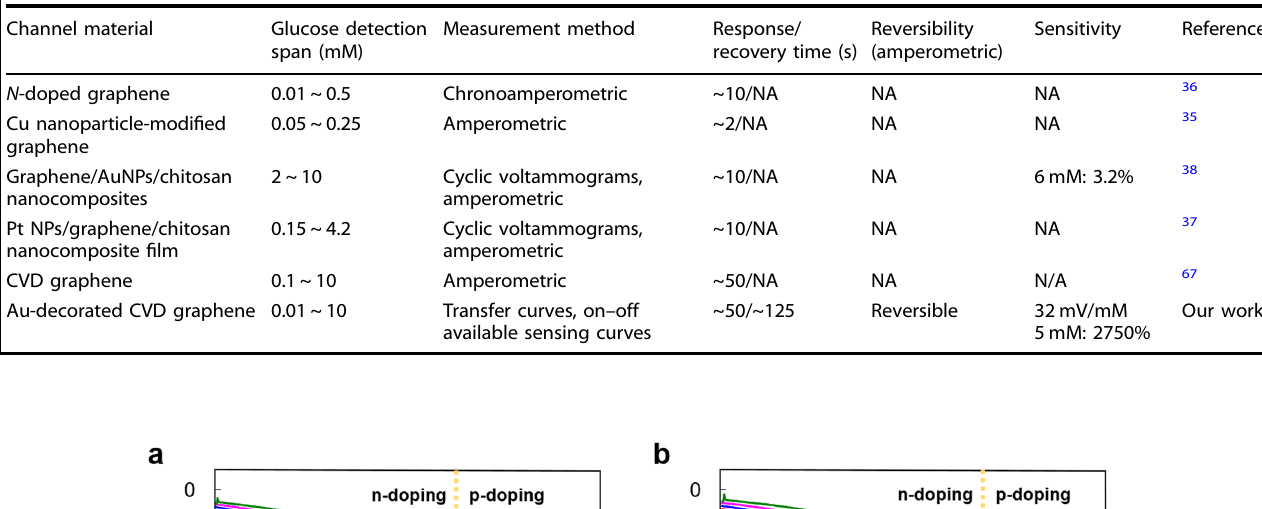
Table 2. Comparison of graphene-based glucose sensors.